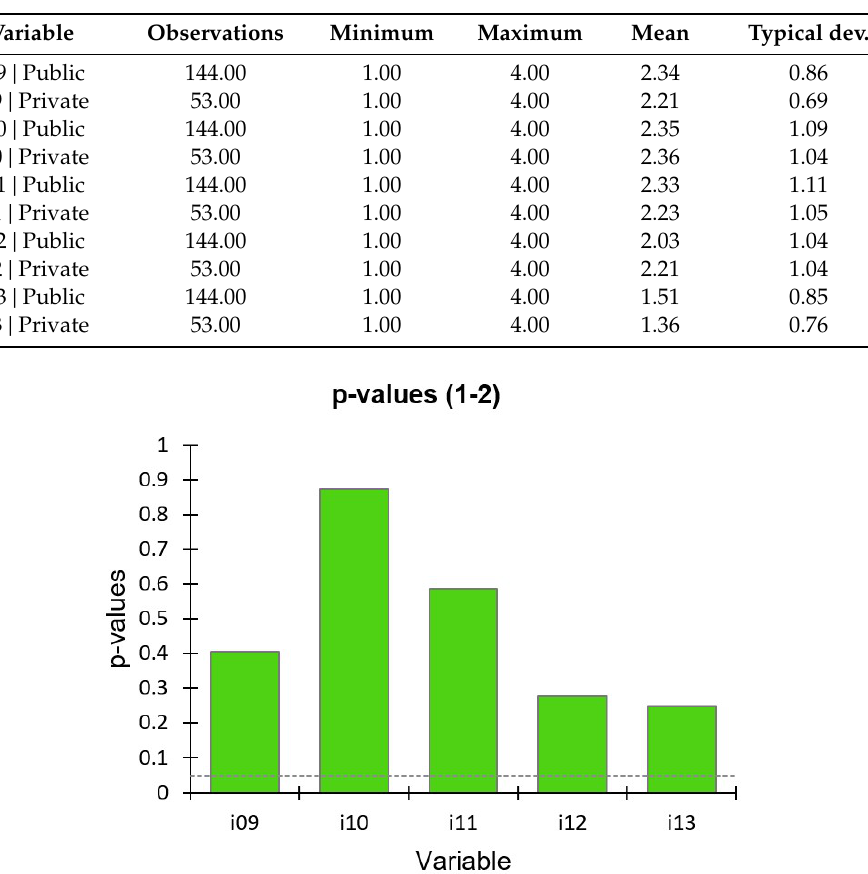
Table 9. Descriptive statistics of the items regarding the educational design of the program according to whether it is public or private.